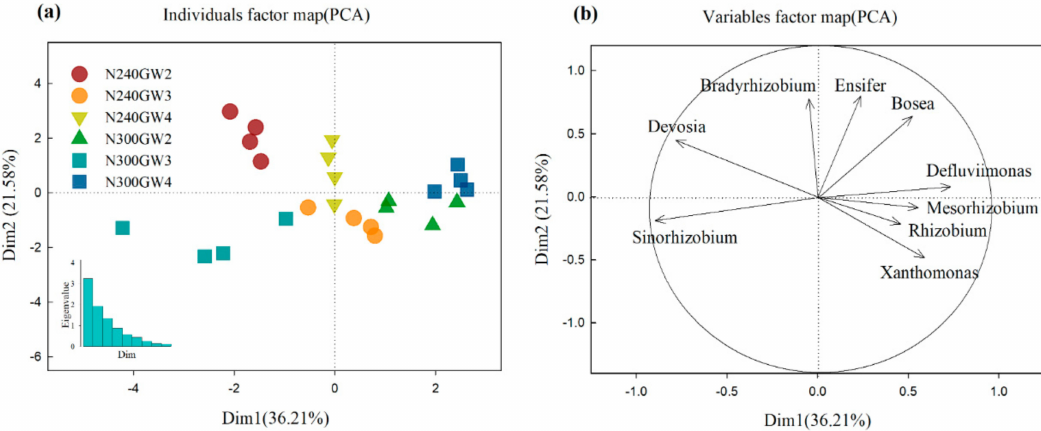
Figure 2. Individuals and variables graph in principal component analysis for nir K-type denitrifier communities. We used taxonomic abundances data from 9 nir K-type dominant genera (relative abundance greater than 1.0%) as quantitative variables, which were used to perform the